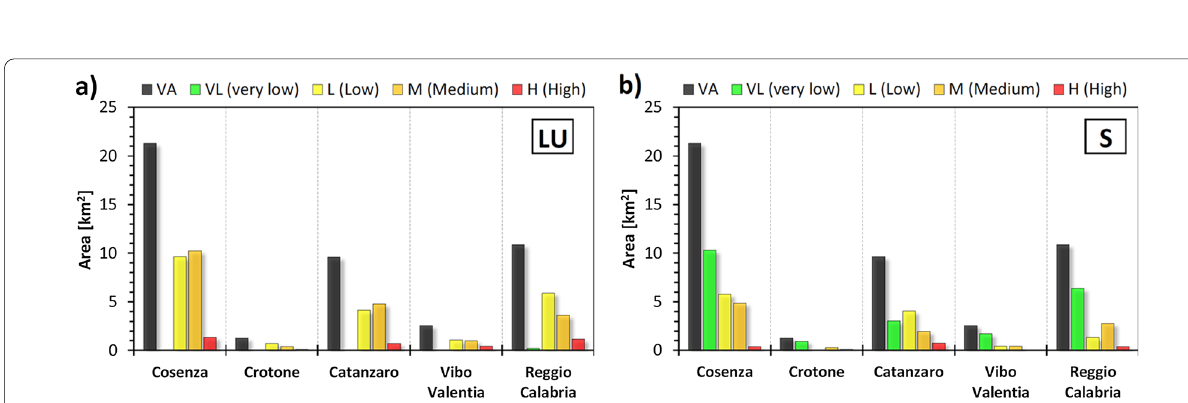
Fig. 13 Distribution of VAs recorded within the five administrative Provinces of the Calabria Region based on the qualitative indicators separately associated with a LU and b S